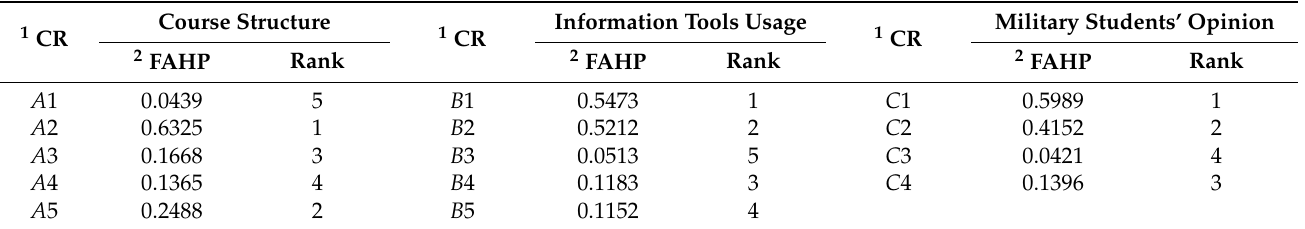
Table A1. The aggregated initial criteria importance weight scores presented by the expert groups.